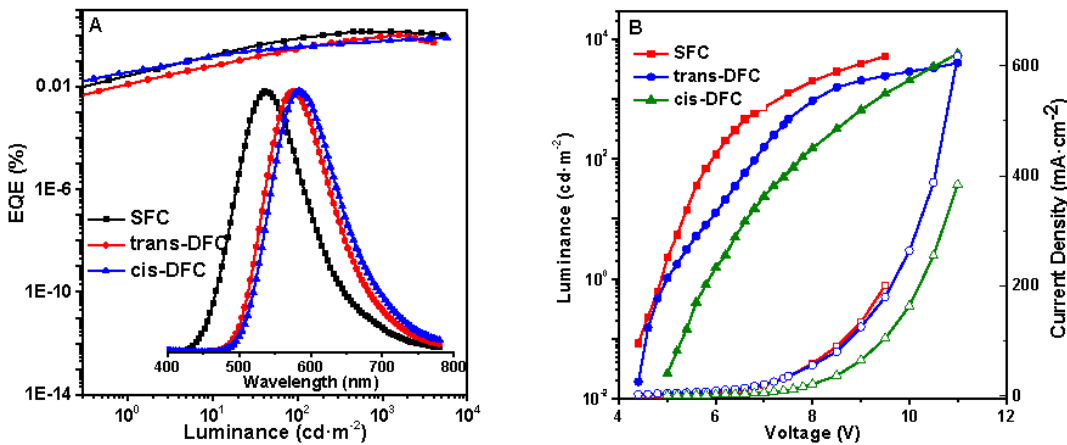
Figure 7. ( A ) EQE of SFC, trans -DFC, and cis -DFC and their normalized EL spectra; ( B ) Luminance– voltage–current density characteristics of multilayer EL devices of SFC, trans -DFC, and cis -DFC. Table 2. EL data of SFC, trans -DFC, and cis -DFC.